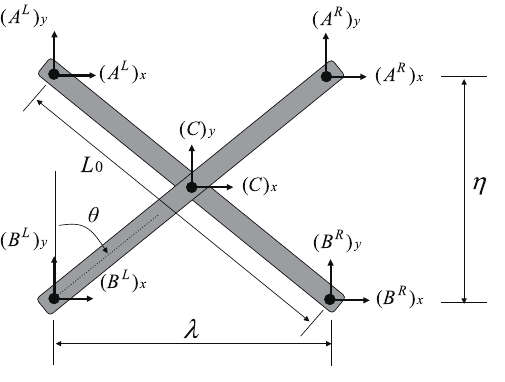
Figure 1. FBD of a scissor